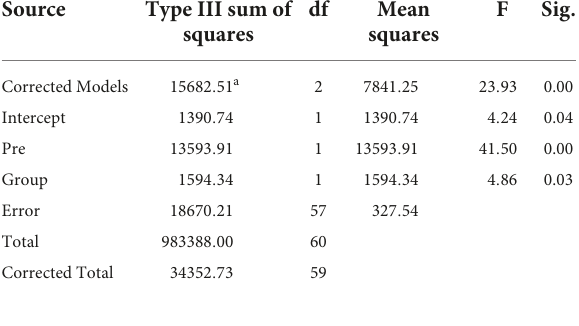
TABLE 4 Inferential statistics of both groups on the motivation